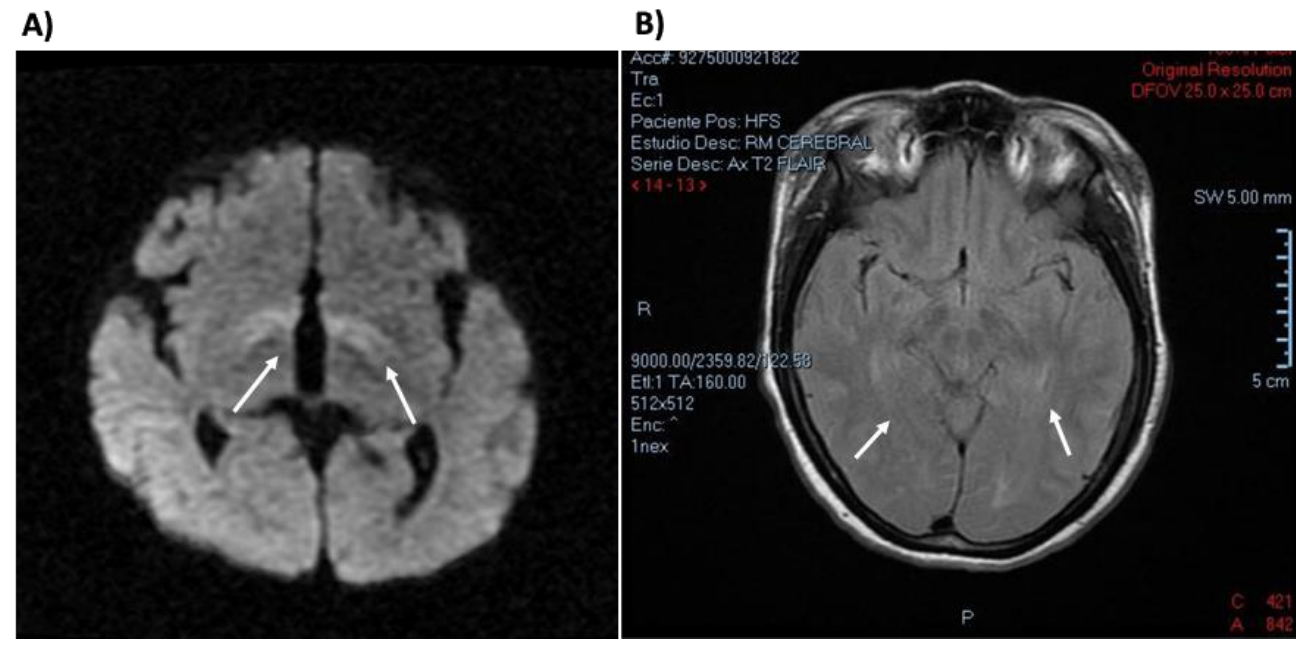
Figure 4. Brain NMRI imaging of two CD patients diagnosed with homozygous genotype c. 60 + 5G > T, and cPKU phenotype. ( A ) Diffusion NMRI of one-year-old male, showing restricted diffusion in periventricular white matter and basal ganglia (arrows). Hypomyelination and brain atrophy were also observed. ( B ) Axial T2 FLAIR imaging of a 10-year-old female showing periventricular white matter hyperintensity (arrows).